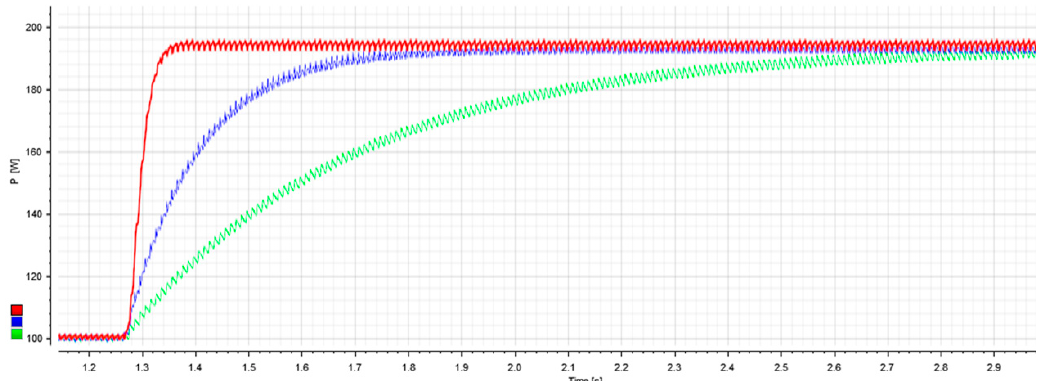
Figure 16. HIL P av results for a Z NL drawing a symmetrical current with peak values from ± 2.48 A to ± 4.15 A after a step perturbation at 1.28 s ( P droop in green, P adv in blue, P DSOGI in red).